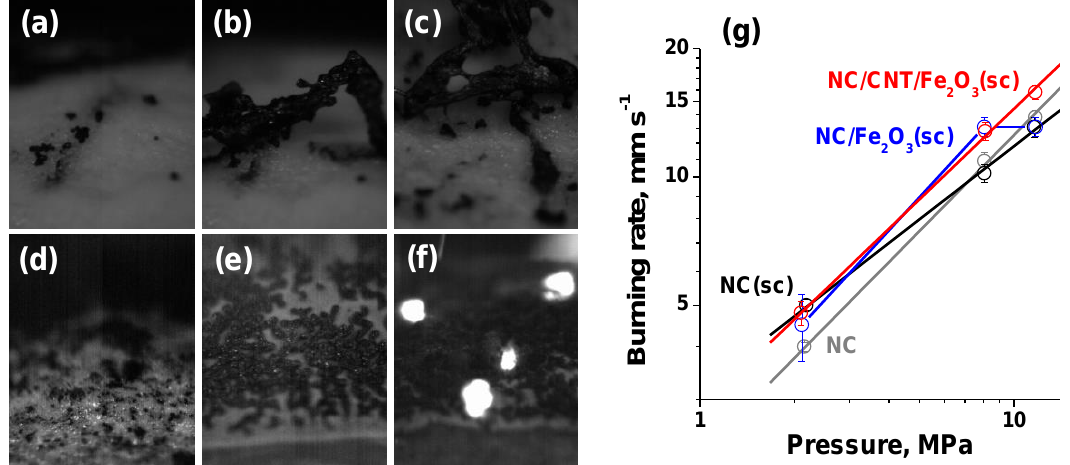
Figure 5. Combustion of the composites: still images from the high-speed filming ( a–f ) and the burning rate-pressure dependencies ( g ). Images shows the typical shots of NC ( a , b ), NC(sc) ( c ), NC / CNT(sc) ( d ), NC / Fe 2 O 3 (sc) ( e ), and NC / CNT / Fe 2 O 3 (sc) ( f ) burning. Frame width is 1.22 mm.